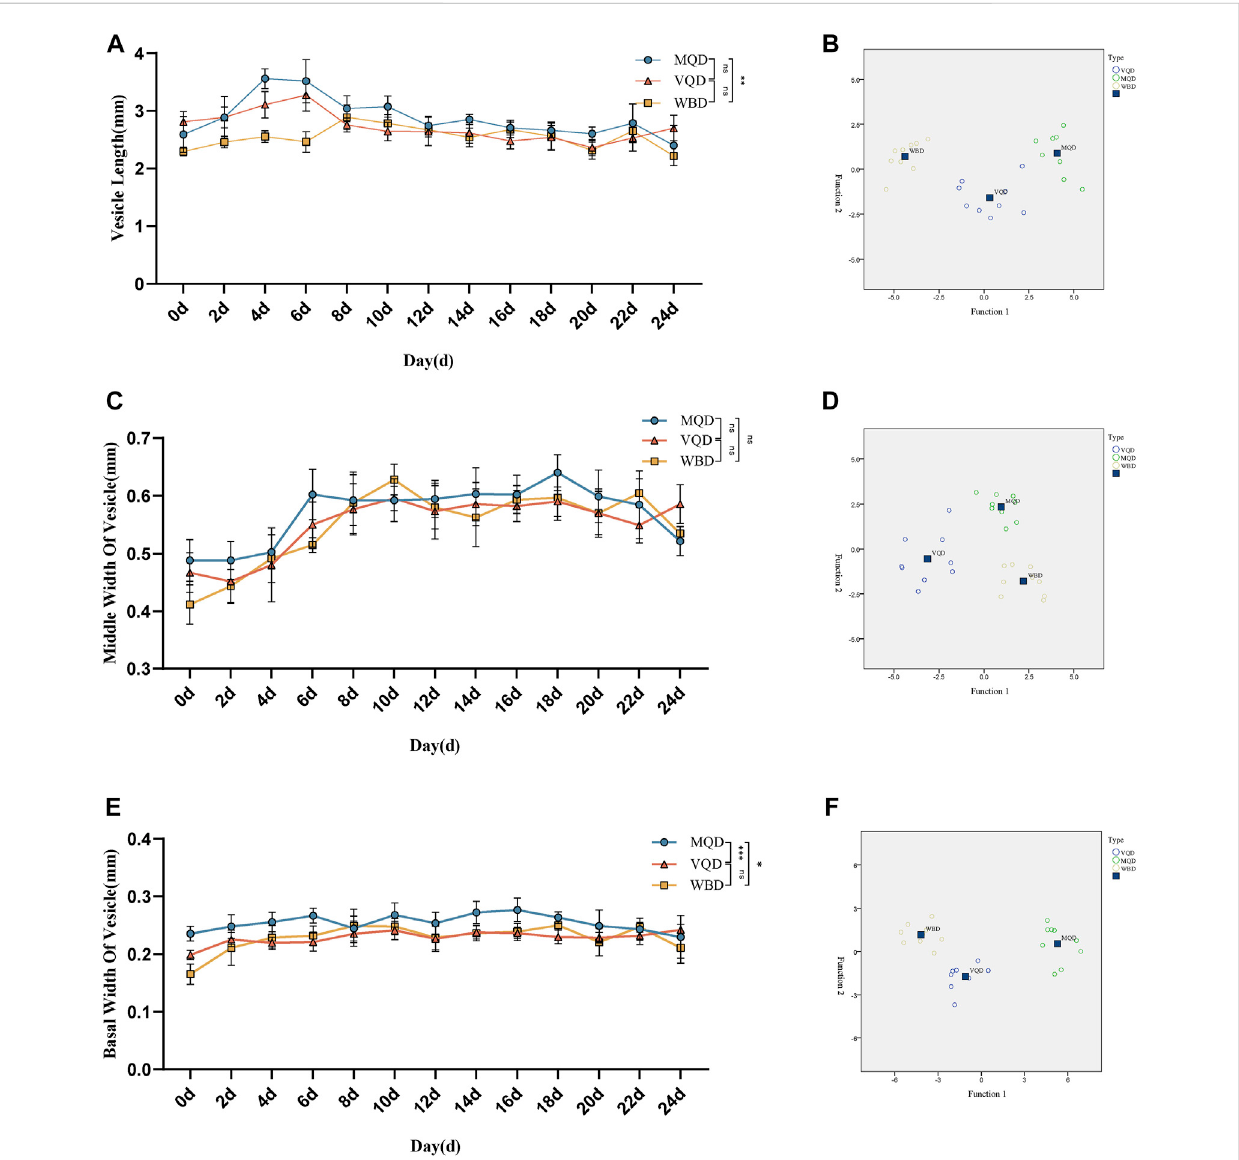
Age-relateddevelopmentprocesses ofseminalvesiclesindrones: (A) length ofseminalvesicles; (B) discriminant analysis oflength; (C) middlewidth ofseminalvesicles; (D) discriminantanalysisofmiddlewidth (E) basalwidthofseminalvesicles (F) discriminantanalysisofbasalwidth. MQD:dronesfrom mated queens; VQD: drones from virgin queens; WBD: drones from worker